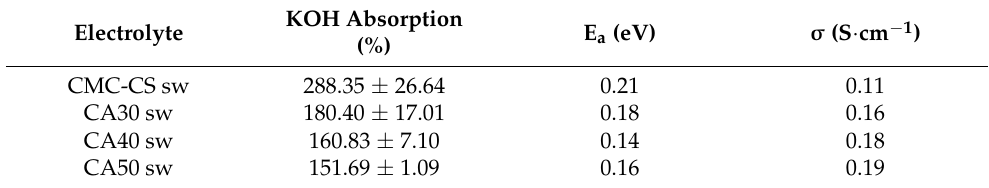
Figure 7. Ionic conductivity of the CMC-CS sw electrolytes at different temperatures. Inset: Activation energy (E a ) of the CMC-CS sw electrolytes. Table 3. Swelling ratio and some electrochemical values obtained for the CMC-CS and CMC-CS-CA sw electrolytes. Ionic conductivity values were obtained at T = 30 °C.